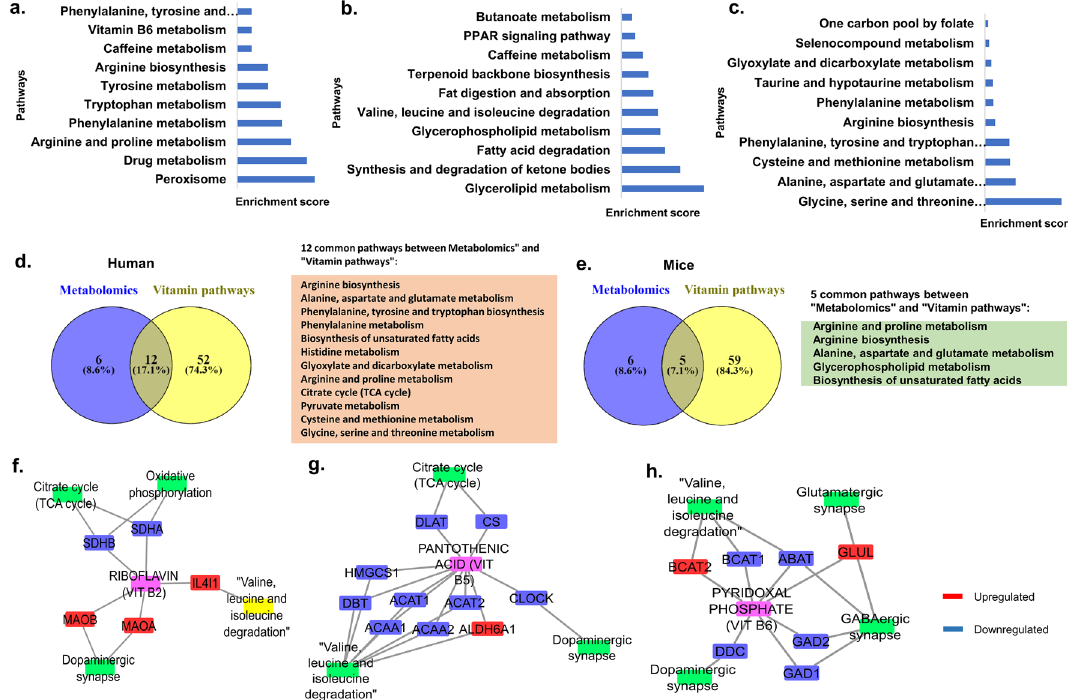
Figure 6. Pathway analysis of vitamin co-factor network. Top significant pathways from ( a ) . Vitamin-B 2 ( b) . Vitamin-B 5 ( c ). Vitamin-B 6 . Commonality analysis ( d ). Pathways common between human metabolomics and pooled vitamin-cofactor analysis ( e ). Pathways are common between mice metabolomics and pooled vitamin co-factor analysis. Network representing cofactor network of ( f ). B 2 with metabolomic pathways. ( g ). B 5 with metabolic pathways ( h ). B 6 with metabolic pathways. Figure generated using Microsoft powerpoint 2019 MSO(Version 2212 Build 16.0.15928.20196) 64-bit, cytoscape (cytoscape 3.8.2) cytoscape/cytoscape/3.8.2/. Venny